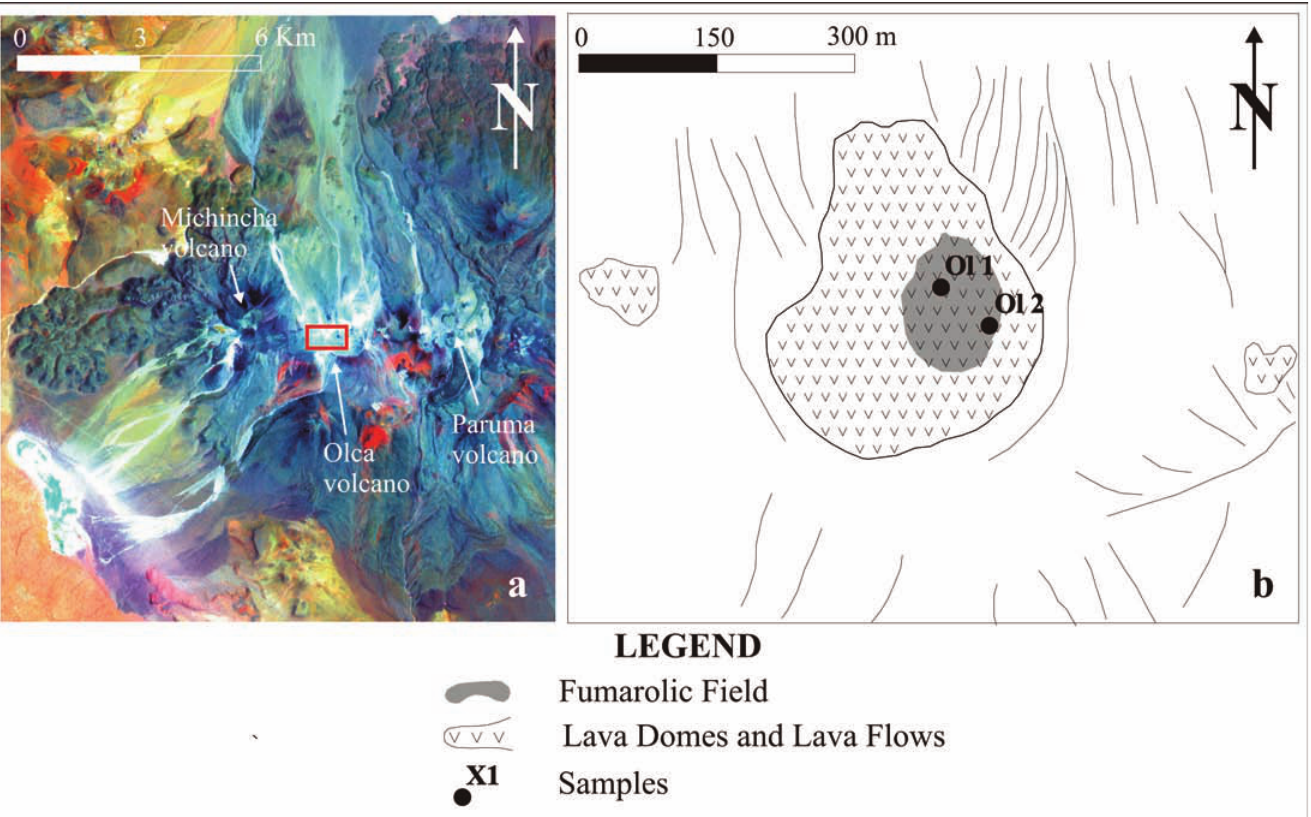
Figure 3. Aerial photograph (a) and schematic map (b) of the summit crater of Olca volcano, showing the locations of the fumarolic fields and sampling